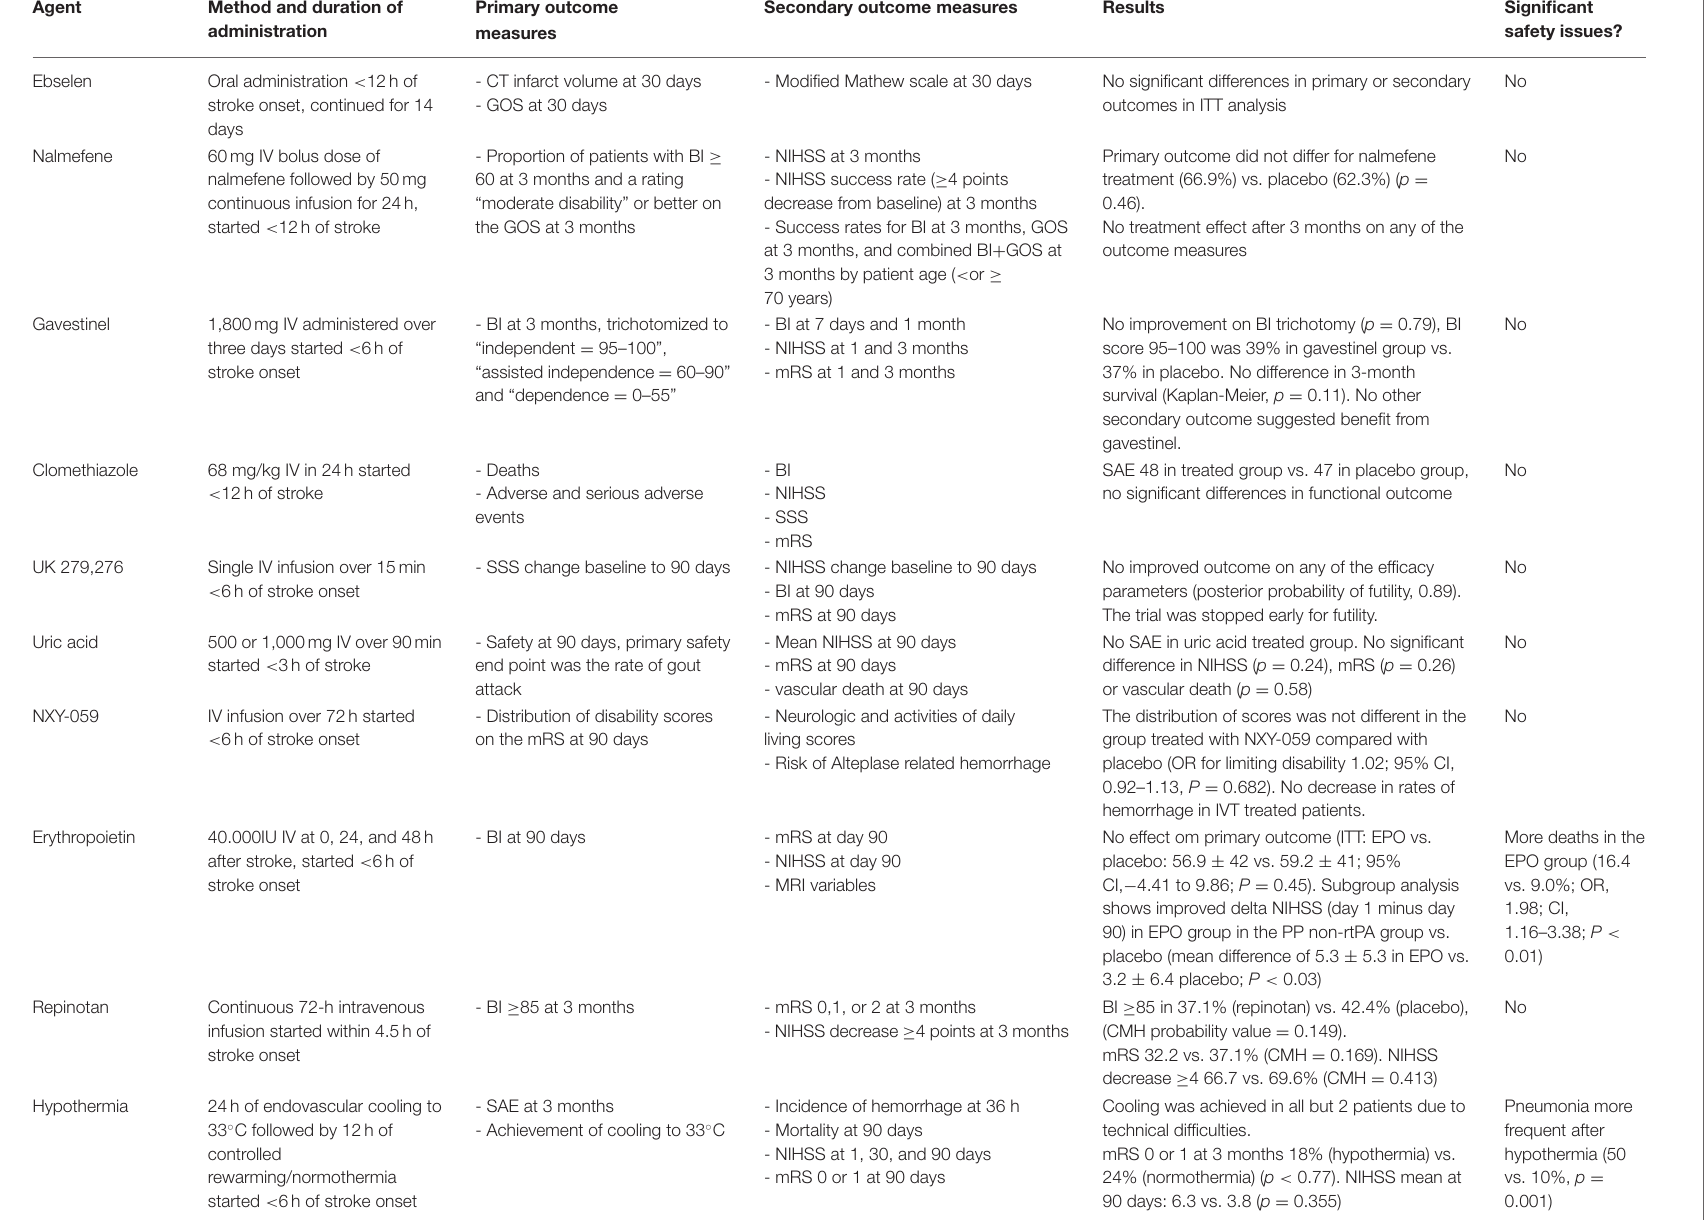
TABLE 2 | Interventions, outcome measures, and results in neuroprotective